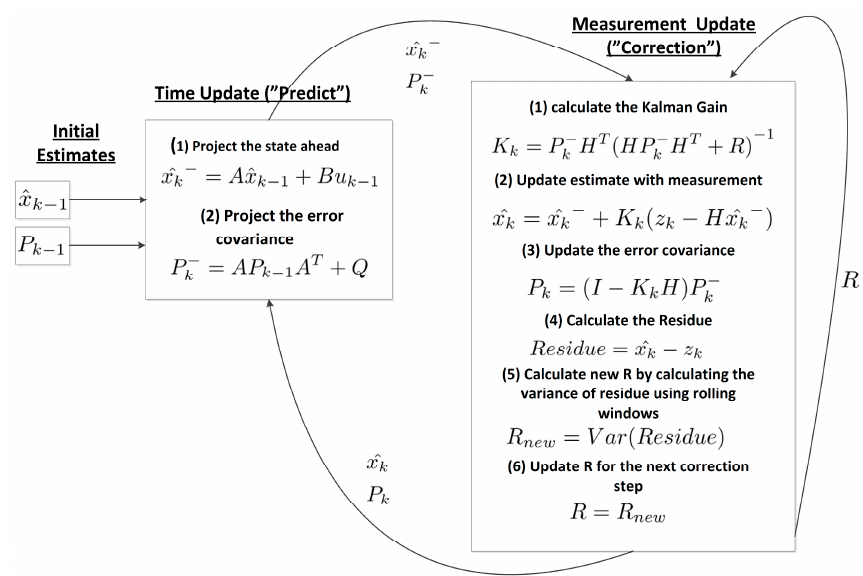
Figure 3. Kalman filter windowing method overview.